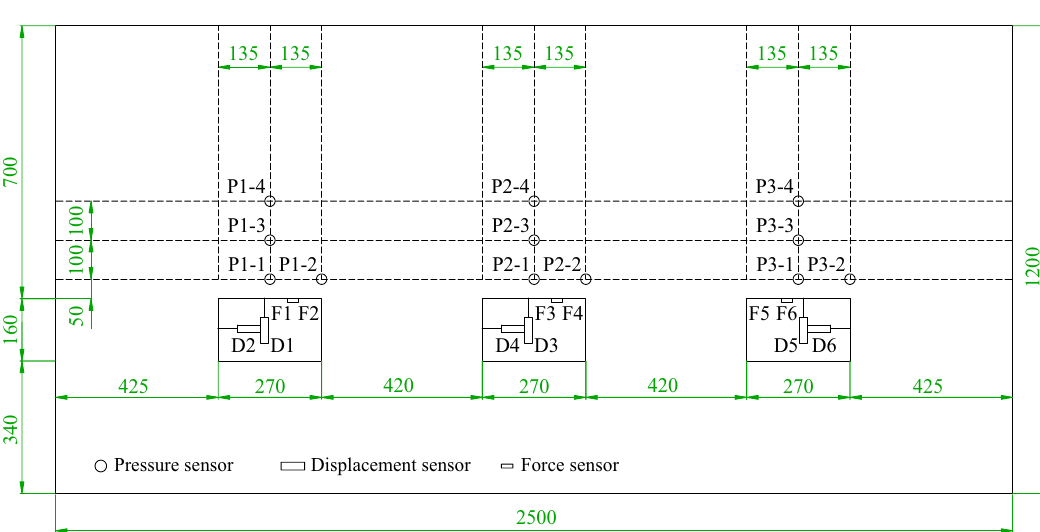
Figure 11. Sensor layout